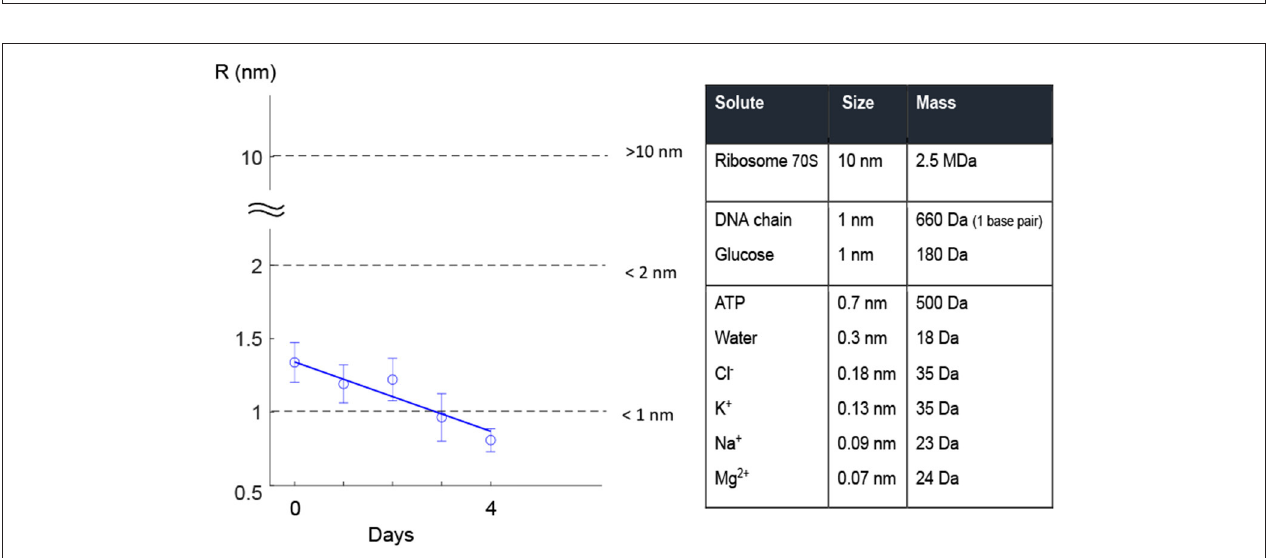
FIGURE 6 | Leak of solutes through small pores. Literature research in filter membranes shows that solutes such as glucose, some ions, and ATP are small enough to pass through pores up to 1 nm size. Bigger pores may allow pass of bigger molecules such as DNA and dextrans 1 .